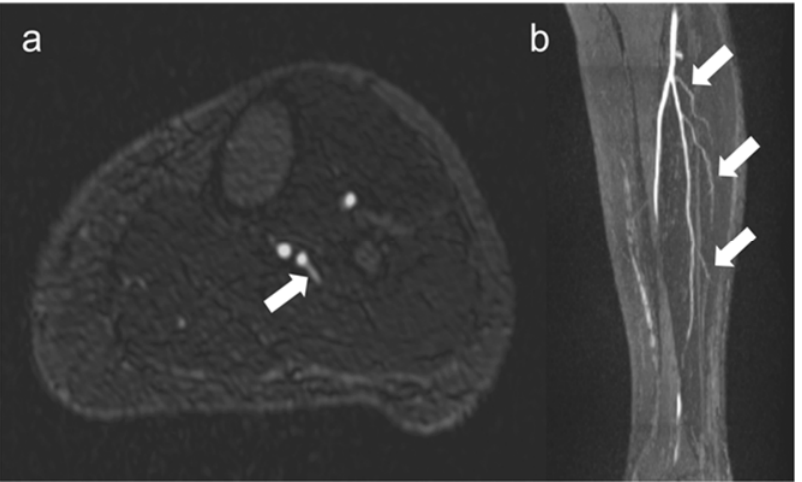
Figure 4. Visualization of fibular perforators using QISS ‐ MRA. In panel ( a ), the exit of a fibular perforator is seen in transverse view (white arrow). In panel ( b ), three fibular perforators can be seen in sagittal view (white arrows). The images belong to two different patients. The median number of perforators varied within patients (2 [1, 3]) and also between the right and left legs (2 [1, 3] vs. 3 [1, 3], p = 0.24). There were no significant differences between the two observers concerning the determination of perforators (Table 3).